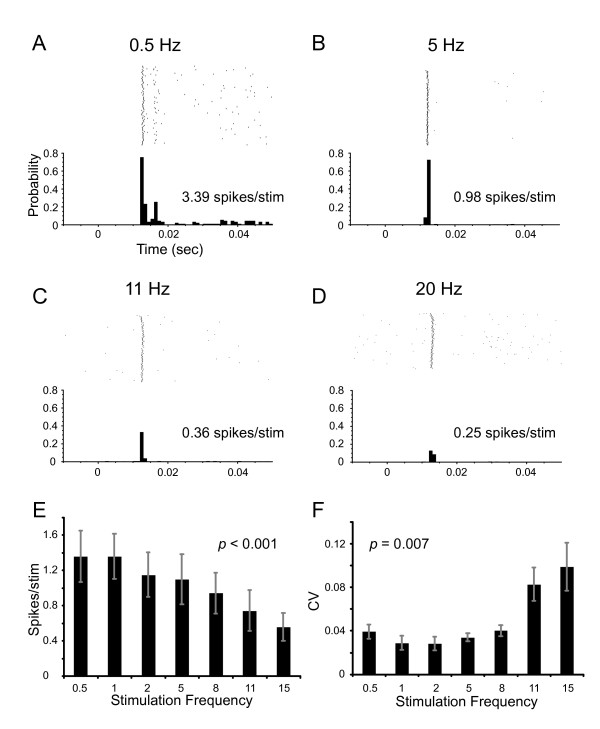
Response adaptation in the superior colliculus. PSTHs (A-D) show response characteristics of a single cell over a range of stimulation frequencies. Significant response magnitudes are indicated for each PSTH. E: Response magnitude decreases significantly as stimulation frequency increases (Friedman's test, P < 0.001). F: Phase-locking, measured as the coefficient of variation (CV) of the latency, also decreases significantly with increasing frequency stimulation (P = 0.007), but the CV remains relatively low even at high frequency.